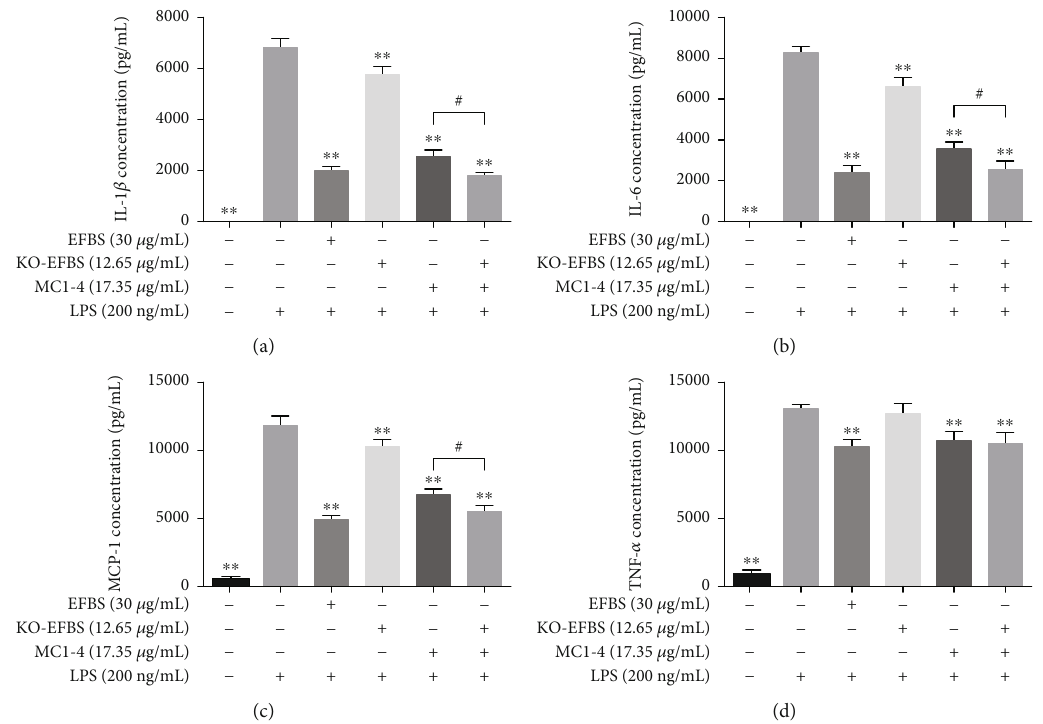
Figure 9: Proin fl ammatory cytokines inhibitory e ff ect of KO-EFBS and MC1-4. Statistical analysis was performed using one-way ANOVA followed by the Tukey-Kramer posttest. ∗∗ P < 0 : 01 compared with LPS treatment group. # P < 0 : 05